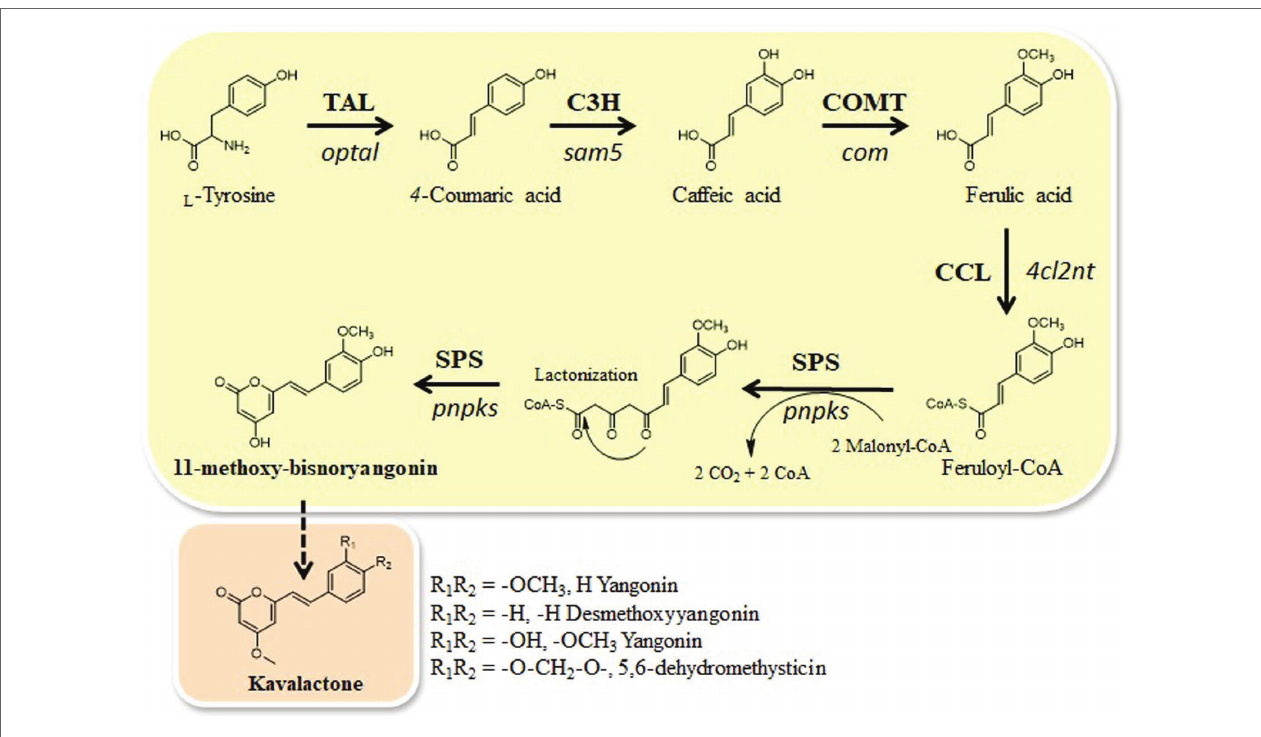
FIGURE 1 | Engineered biosynthetic pathways for styrylpyrone compound, 11-methoxy-bisnoryangonin, starting from L -tyrosine in E. coli and the proposed kavalactone biosynthetic pathway. Tyrosine ammonia-lyase (TAL) gene ( optal ), C3H (4-coumarate 3-hydroxylase) gene ( sam5 ), COMT (caffeic acid O -methyltransferase) gene ( com ), CCL gene ( 4cl2nt ), and SPS gene ( pnPKS ). Bold arrows indicate the major synthetic pathway used in this